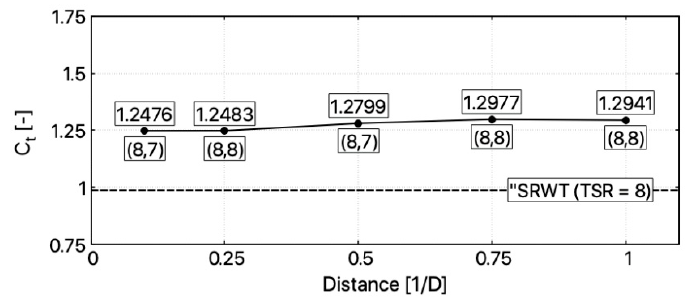
Figure 11. Thrust coe ffi cient C t for optimal operational point for di ff erent Figure 11. Thrust coefficient C t for optimal operational point for different configurations. Figure 11. Thrust coefficient C t for optimal operational point for different configurations. Figure 11. Thrust coefficient C t for optimal operational point for different configurations.